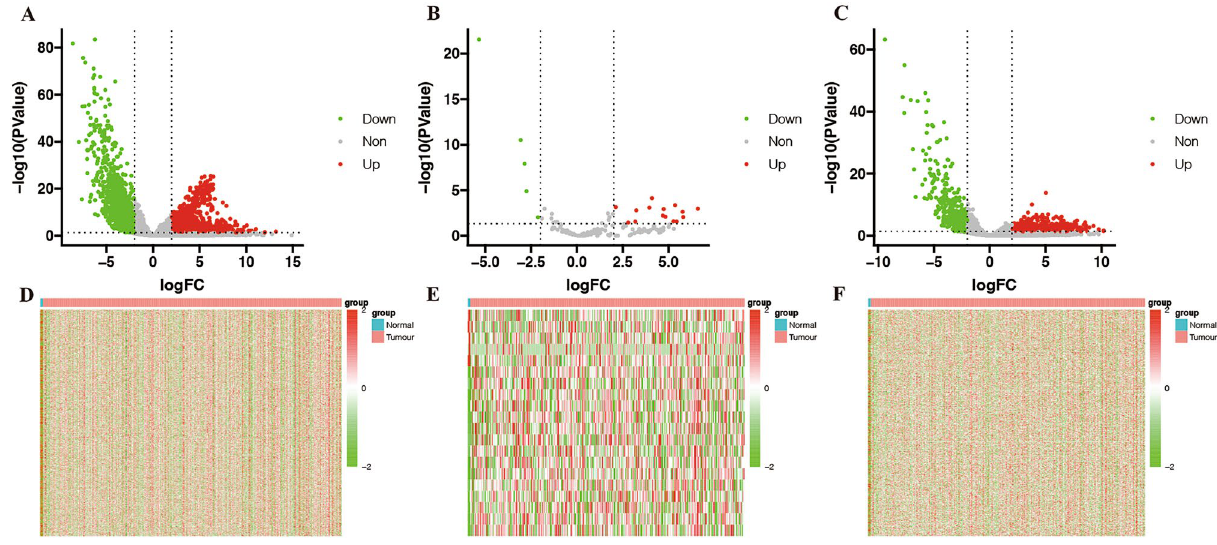
Figure 2. Differentially expressed RNAs between CESC and adjacent normal tissues. Volcano plot of the differentially expressed ( A ) mRNAs, ( B ) miRNAs and ( C ) lncRNAs. Red indicates high expression, and green indicates low expression. Black indicates no significant difference in expression. Heat map of the overall expression landscape of the differentially expressed ( D ) mRNAs, ( E ) miRNAs, and ( F ) lncRNAs.